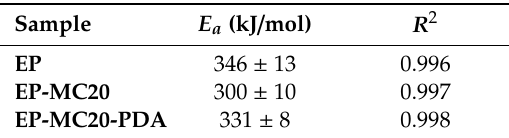
Table 5. Main results of DMA multifrequency tests on the prepared composites. Activation energy ( E a ) and value of R 2 of the linear